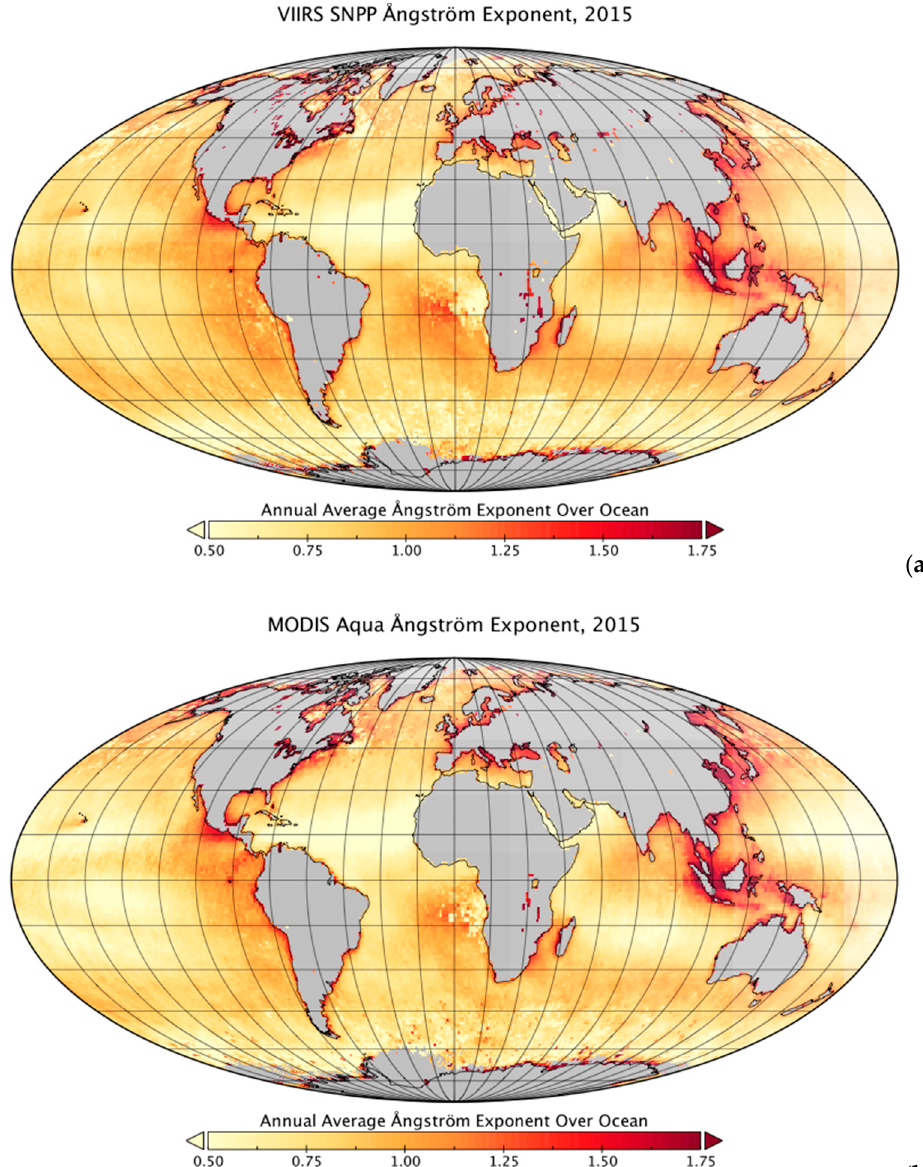
Figure 16. Annual average Ångström exponent (calculated from the annual gridded average AODs at 0.55 µ m and 0.86 µ m) over ocean, from ( a ) VIIRS SNPP (mean 0.87) and ( b ) MODIS Aqua (mean 0.84).